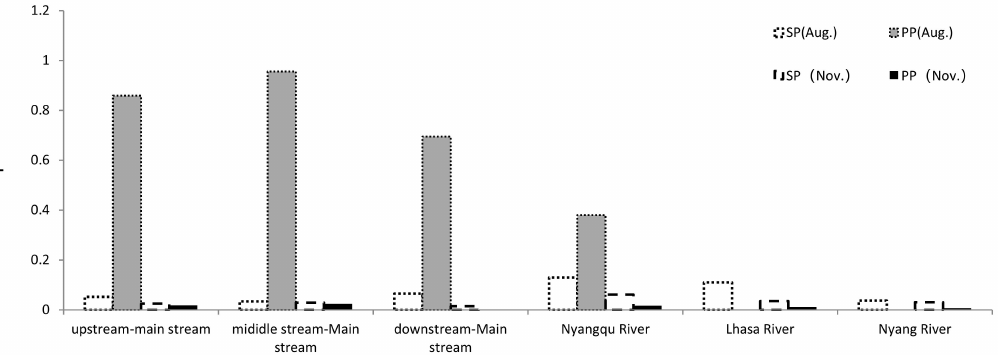
Figure 6. P in the water–sand